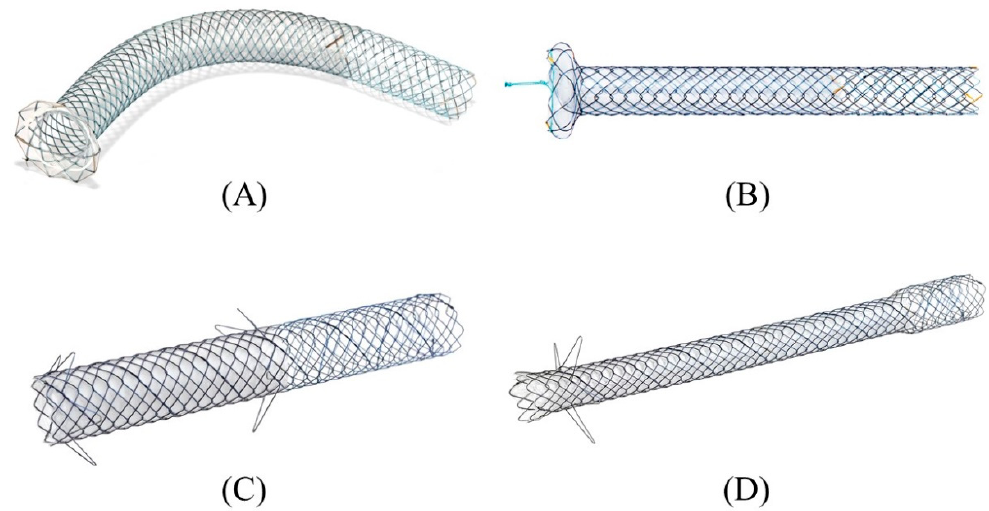
Figure 16. Partially covered SEMSs with anti-migration properties dedicated for EUS-HGS developed by Korean companies. GIOBOR stent (Taewoong medical) ( A ). HANARO stent BPD (M.I.Tech, Seoul, Korea) ( B ). Hybrid BONA stent (Standard Sci. Tech, Seoul, Korea) ( C ). DEUS (Standard Sci. Tech) ( D ). Courtesy of each company.